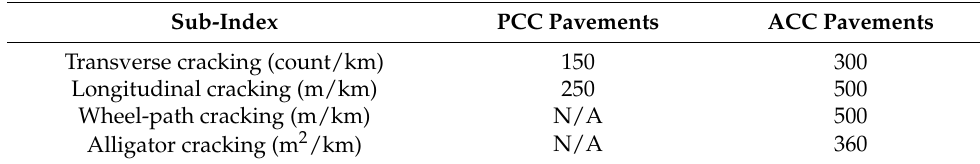
Table 1. Threshold value for different